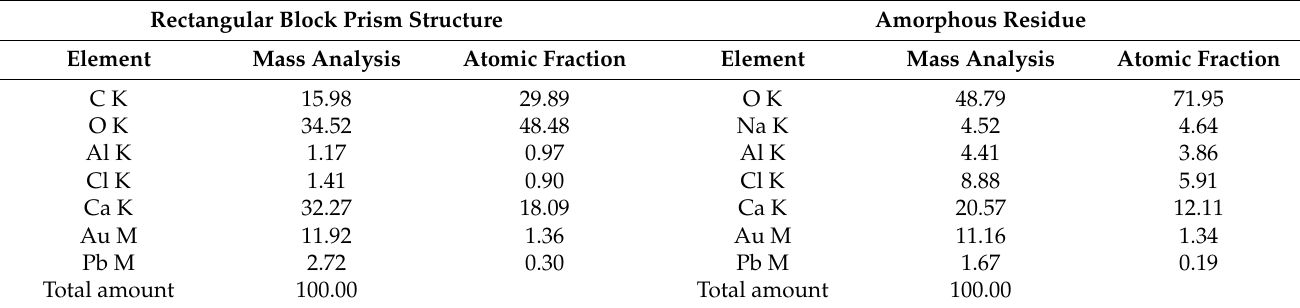
Table 6. EDS test results of calcium chloroaluminate solidified